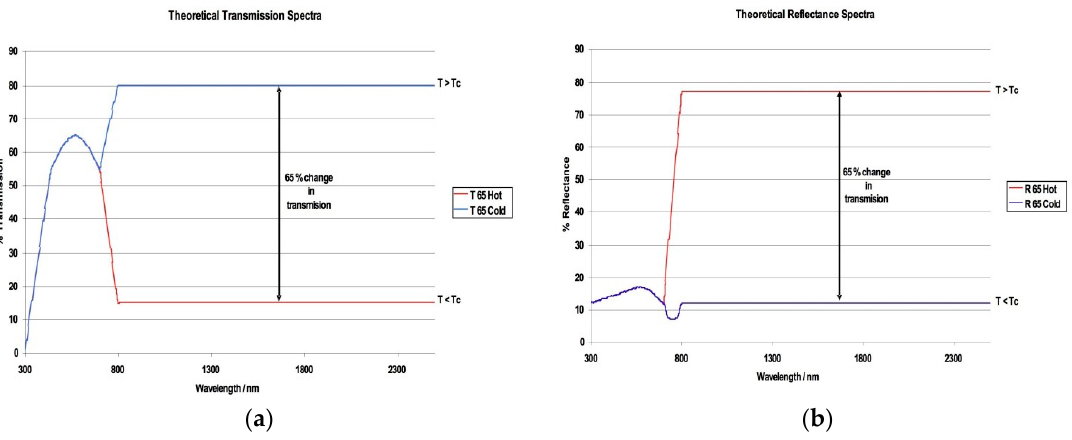
Figure 13. Idealized UV ‐ Vis spectra for a thermochromic VO 2 glazing, with ( a ) transmittance and ( b ) reflectance modulations [157].